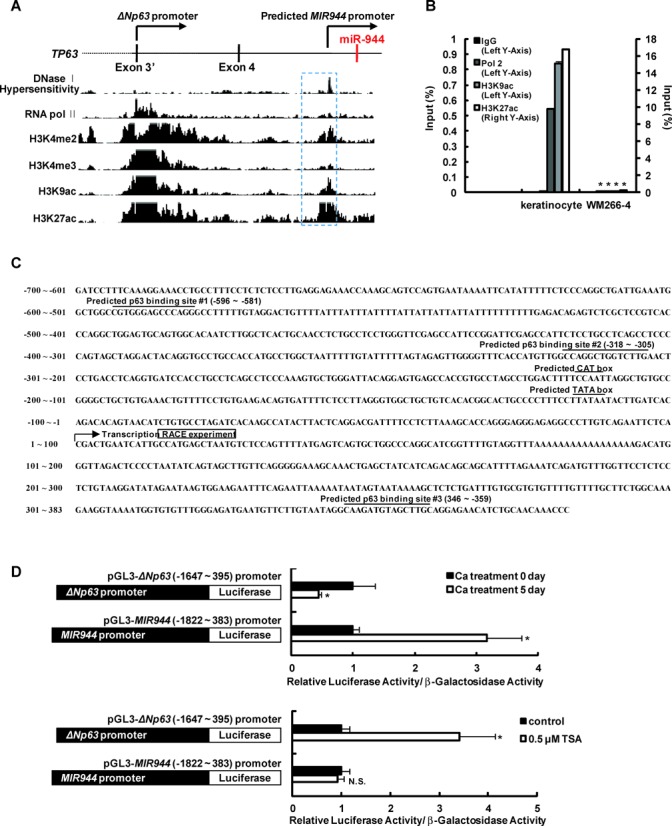
Identification of a MIR944 promoter that is independent of the host gene ΔNp63 promoter. (A) UCSC Genome Browser view of DNase I hypersensitivity, RNA pol II, H3K4me2, H3K4me3, H3K9ac and H3K27ac tracks obtained for normal human epidermal keratinocytes at TP63. DNase I hypersensitivity marks transcriptionally active regions; H3K4me2 marks promoter and enhancer activity; H3K4me3 marks promoter activity; and H3K9Ac and H3K27Ac mark open chromatin structure and transcriptional initiation. The predicted promoter of MIR944 is shown in the blue box (dashed line). (B) ChIP-qPCR results for RNA pol II, H3K9ac and H3K27Ac binding to the region of the MIR944 promoter in both keratinocytes and WM266-4 melanoma cells. Data represent the means ± SD of triplicate biological samples and are representative of three different experiments. *P < 0.05 versus keratinocyte, unpaired Student's t-test. (C) Nucleotide sequences in the MIR944 promoter region (−700 to +383). Areas marked with a line indicate possible CAT and TATA boxes and predicted p63-binding sites. The RACE clone closely matches the predicted transcript on the UCSC Genome Browser. The first nucleotide of the transcript from the RACE experiment is numbered as 1. (D) Human primary keratinocytes were transfected with ΔNp63 promoter-luciferase (pGL3-ΔNp63 [−1647 to +395] promoter) or a MIR944 promoter-luciferase construct (pGL3-MIR944 [−1822 to 383] promoter). (Upper panel) Transfected keratinocytes were differentiated by cultivating the cells for the indicated time period in a high-calcium medium (1.2 mM) for 5 days, and luciferase and β-galactosidase activities were then measured. (Bottom panel) Transfected keratinocytes were treated with 0.5 μM TSA. After 1 day of incubation, luciferase and β-galactosidase activities were measured. Luciferase activities were normalized to β-galactosidase activities. Data represent the means ± SD of triplicate biological samples and are representative of three different experiments. *P < 0.05 versus Ca treatment 0 day or control, unpaired Student's t-test.